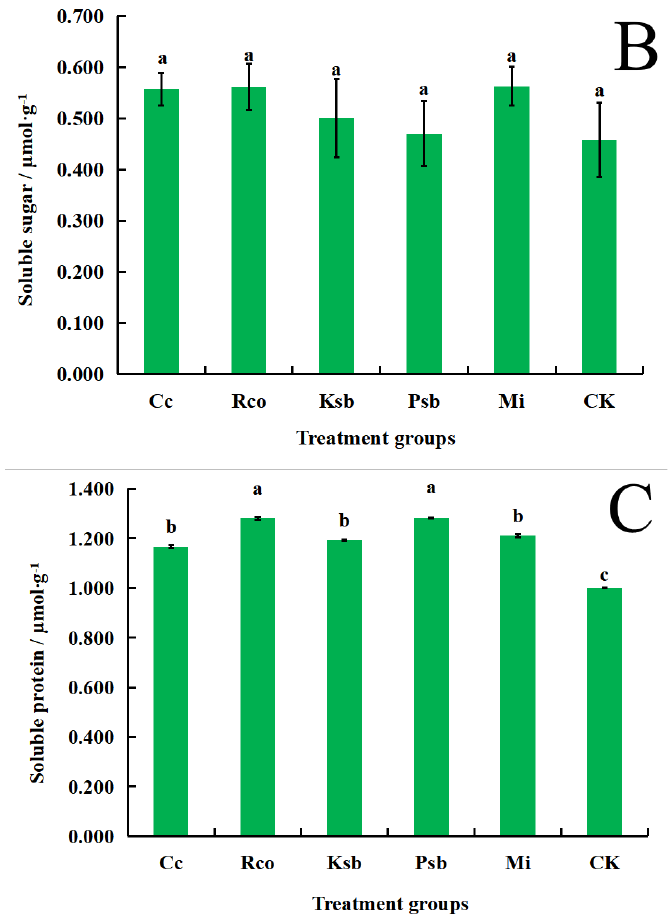
Figure 3. Effect of different microbial inocula on MDA (malondialdehyde), soluble sugar, and soluble protein content of F. taipaiensis leaves. Different lowercase letters indicate significant differences ( p < 0.05) in the infection intensity among the six treatments. The values are means ± standard deviation of 5 plants randomly selected from each treatment. ( A ) MDA, ( B ) soluble sugar, and ( C ) soluble protein content in the leaves of each treatment group. Cc: Claroideoglomus claroideum treatment group, about 1360 C. claroideum spores for each container; Rco: Racocetra coralloidea treatment group, about 1430 R. coralloidea spores for each container; Ksb: potassium solubilizing bacteria treatment group, 35 g Bacillus mucilaginosus inoculum for each container; Psb: phosphorus solubilizing bacteria treatment group, 35 g Bacillus megaterium inoculum for each container; Mi: mixed treatment group with mixed inoculum of C. claroideum , R. coralloidea , B. mucilaginosus , and B. megaterium , the application amount of each microbial inoculum was 1/4 of the former 4 groups; CK: control group, no microbial inocula were used.